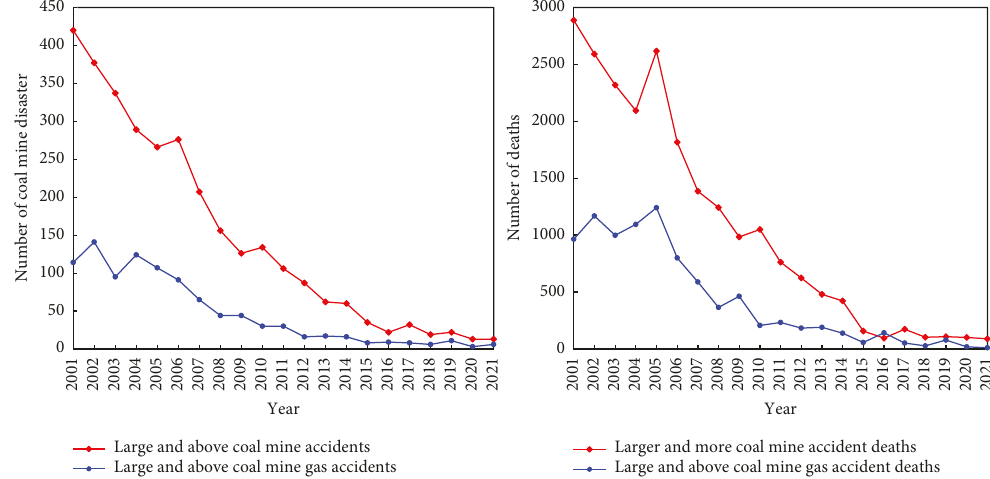
Figure 1: Larger and above coal mine accidents and coal mine gas explosion accidents in recent 20 years in